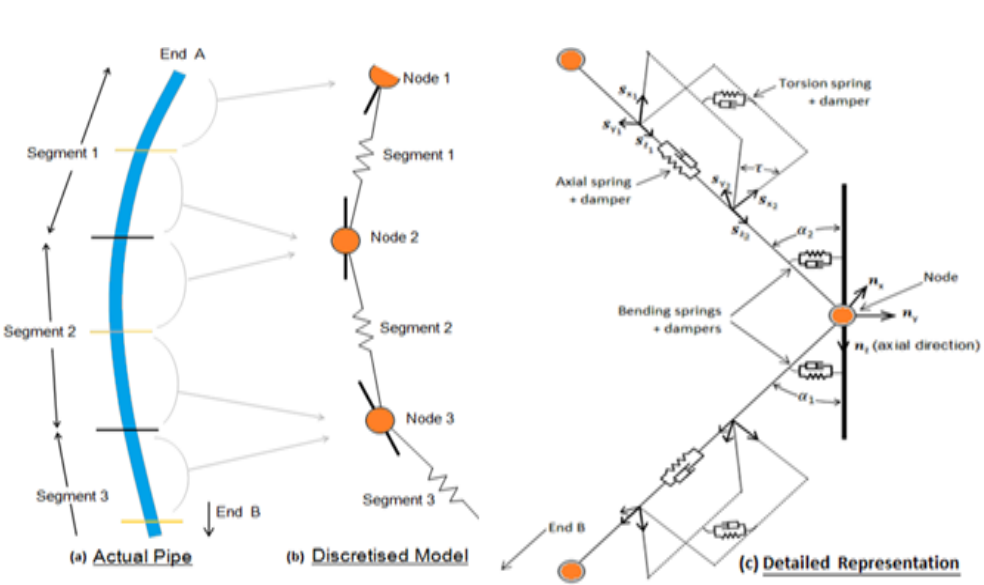
Figure 10. Orcaflex Line Model showing ( a ) the main line, ( b ) the discretized model, ( c ) Detailed model representation with 3 spring-damper types (Adapted, courtesy of Orcina [73]) .